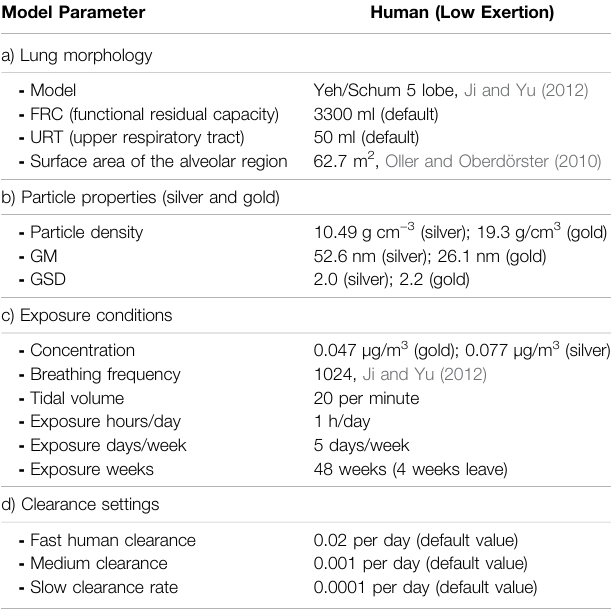
TABLE 1 | Assigned values used in the MPPD modelling. TABLE 2 | Particle mode percentage contribution accounting for both background and gold synthesis